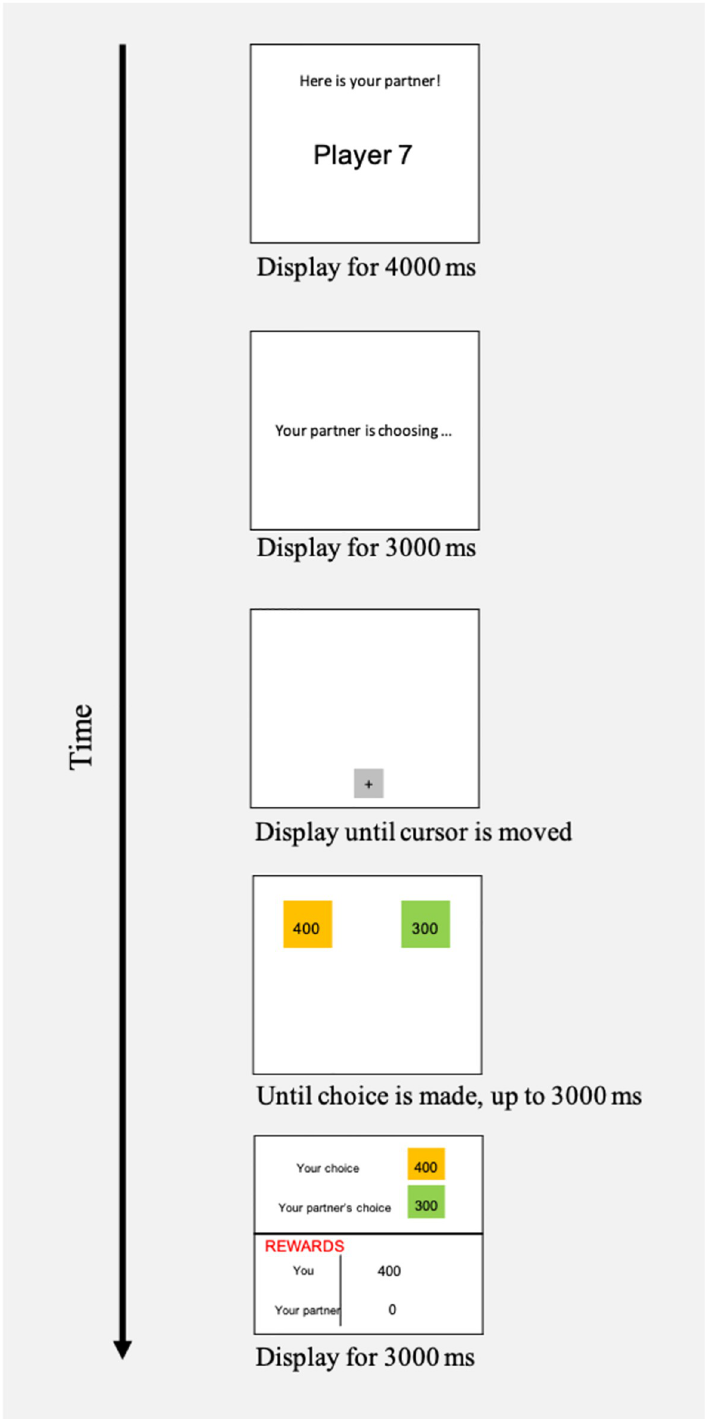
Fig 2. Experiment 1 trial structure. At the beginning of each trial, an image of the partner’s player number was displayed, which was either the same (Fixed Partner Condition) or different (Variable Partners Condition) on every trial. Then, the partner chose one of two values. The participant did not see what these two values were, and did not see what the partner had chosen, but was then herself presented with two values to choose between. One of these, indicated in green or blue, was the same value that the partner had chosen (coordination option); the other, indicated in orange, was an alternative value (alternative option). We varied whether, and to what extent, the alternative option constituted a